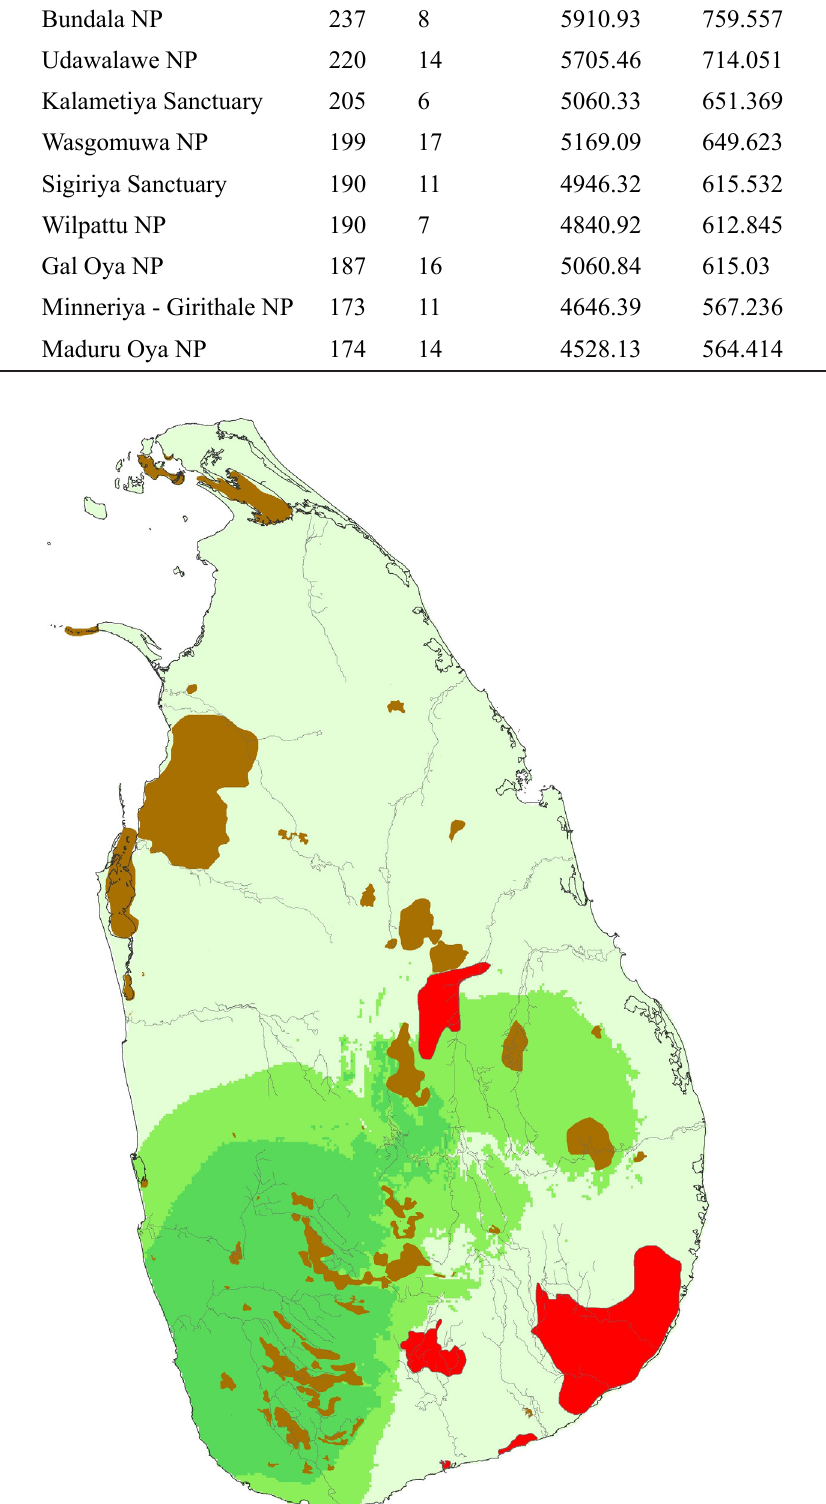
Figure 3: IBAs of Sri Lanka. The top five most evolutionarily diverse (PD, ED and EDGE) IBAs are highlighted in red color. Main climatic zones and main river systems of the island are also indicated in the